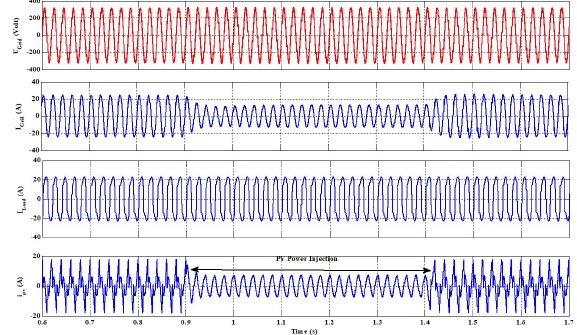
Fig. 3. Multifunctional operation of grid tied PV system.